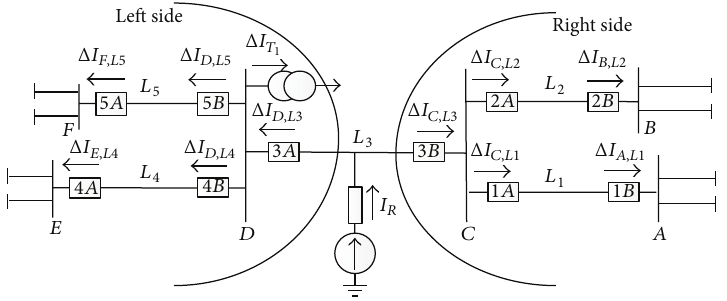
Figure 1: Distribution of fault component